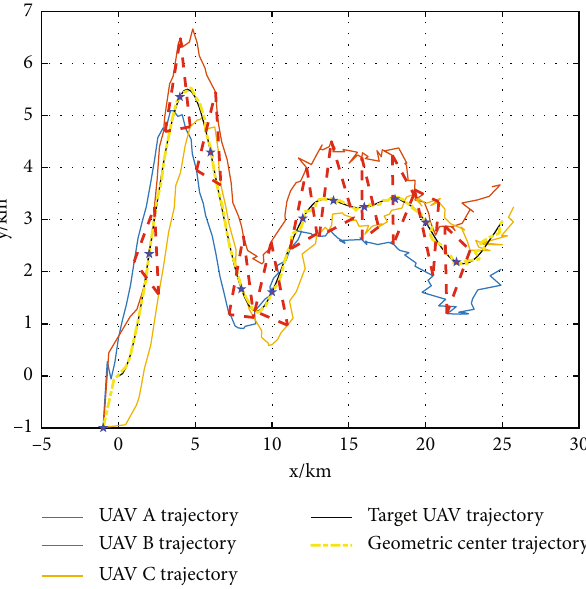
Figure 3: The X - Y coordinate change of the traditional algorithm.